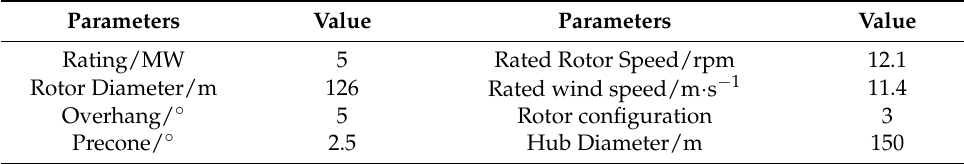
Table 2. Main parameters of NREL 5 MW wind turbine. Parameters